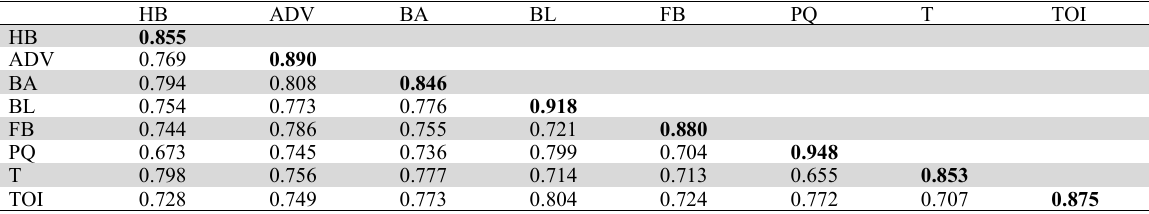
Discriminant Validity: Fornell and Larcker Criterion (1981)